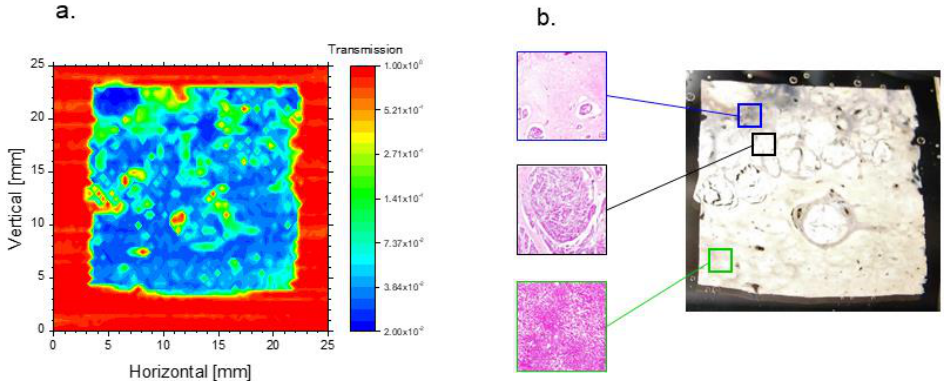
Figure 4. Images of sample #3 by ( a ) infrared free − electron laser imaging and ( b ) photograph. Stained images are shown for the blue, black, and green frames in ( b ).